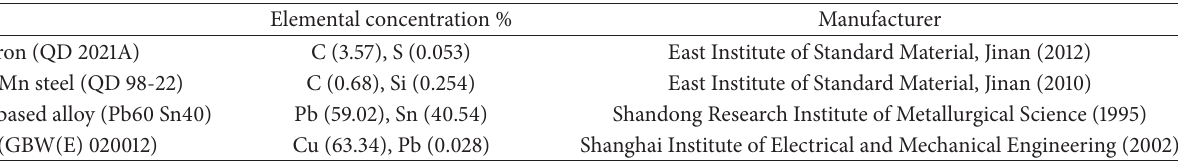
Table 2: Information of the samples.